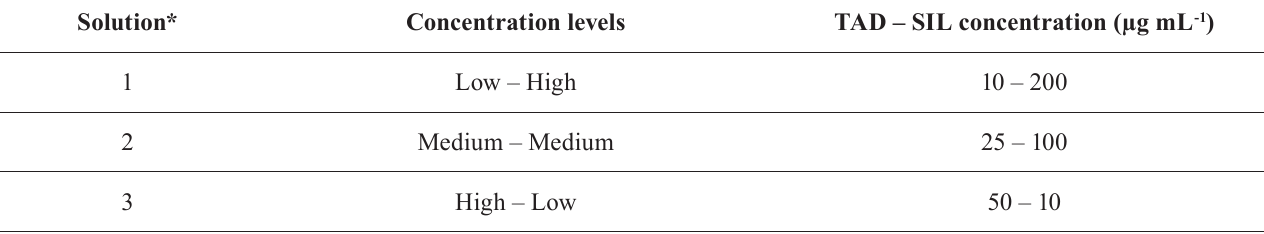
TABLE I - T hree different levels of concentration for recovery test